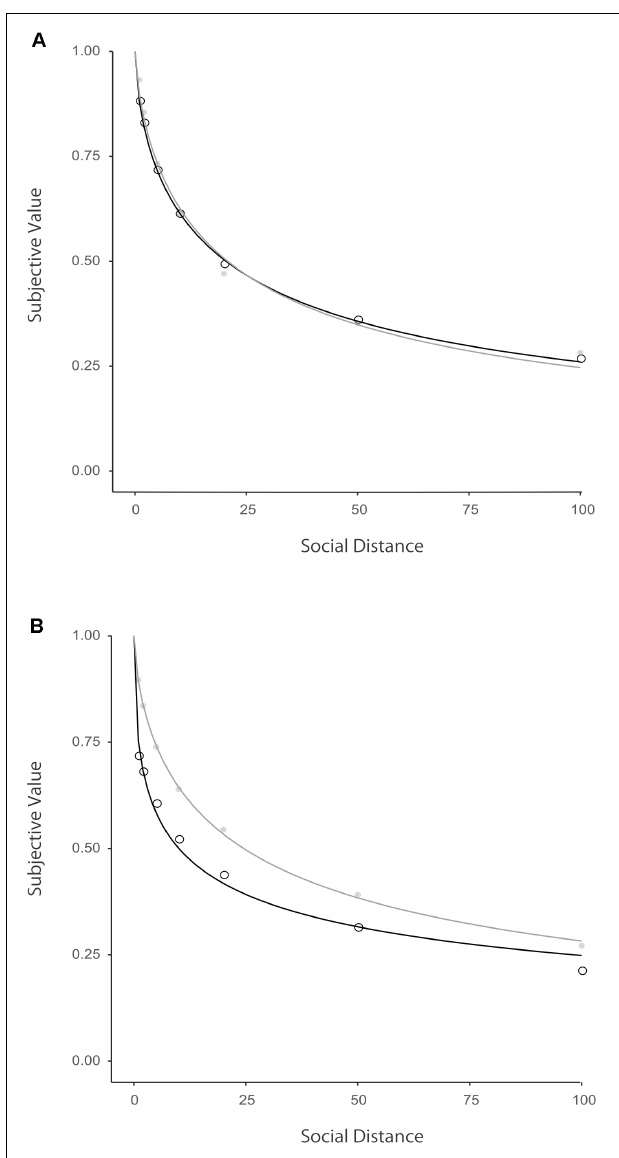
FIGURE 1 | Hyperbolic with exponent functions with social distance for all the participants (German: A , Japan: B ). Mean indifference points were plotted in circle. The curved lines were illustrated in black for gains and in gray for